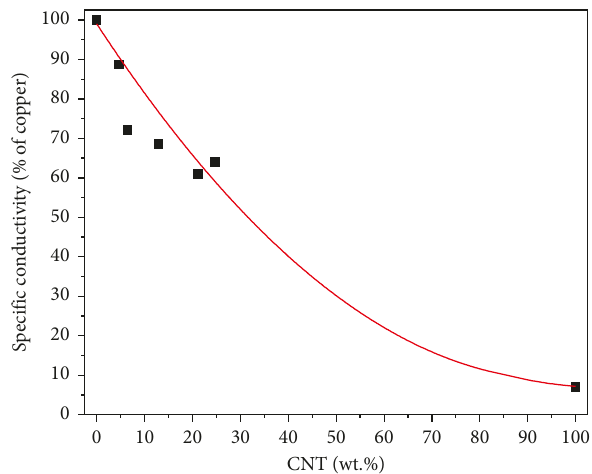
Figure 6: Specific conductivity of CNT-Cu composites prepared by electrodeposition on CNT yarns as a function of CNT wt.%. Pure copper and pristine CNT yarn conductivity is also shown for comparison.